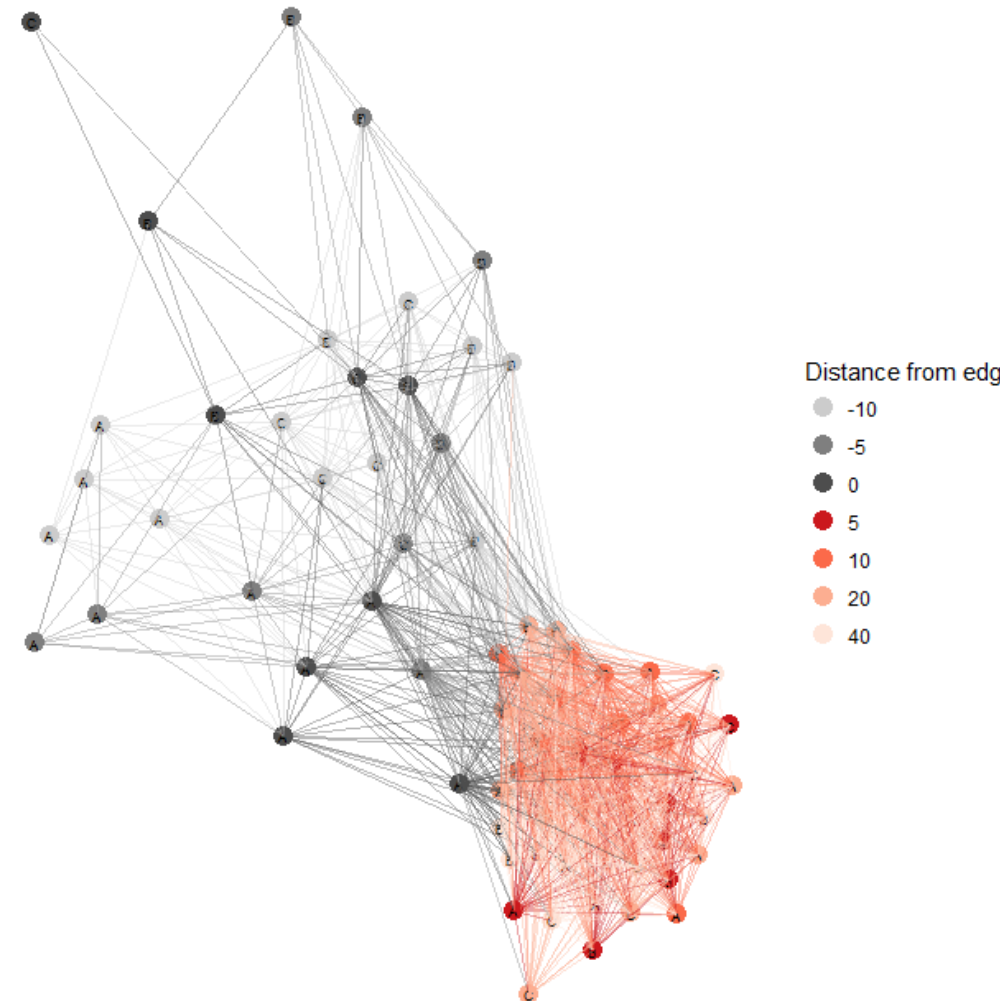
Figure 3. Network analysis of fungal taxa (in terms of relative abundances) in forest floor, coarse soil, fine soil, and root samples, using Bray–Curtis distances less than 0.91 (minimum threshold displaying all 74 samples). Each sample is labeled by transect (A, B, or C).